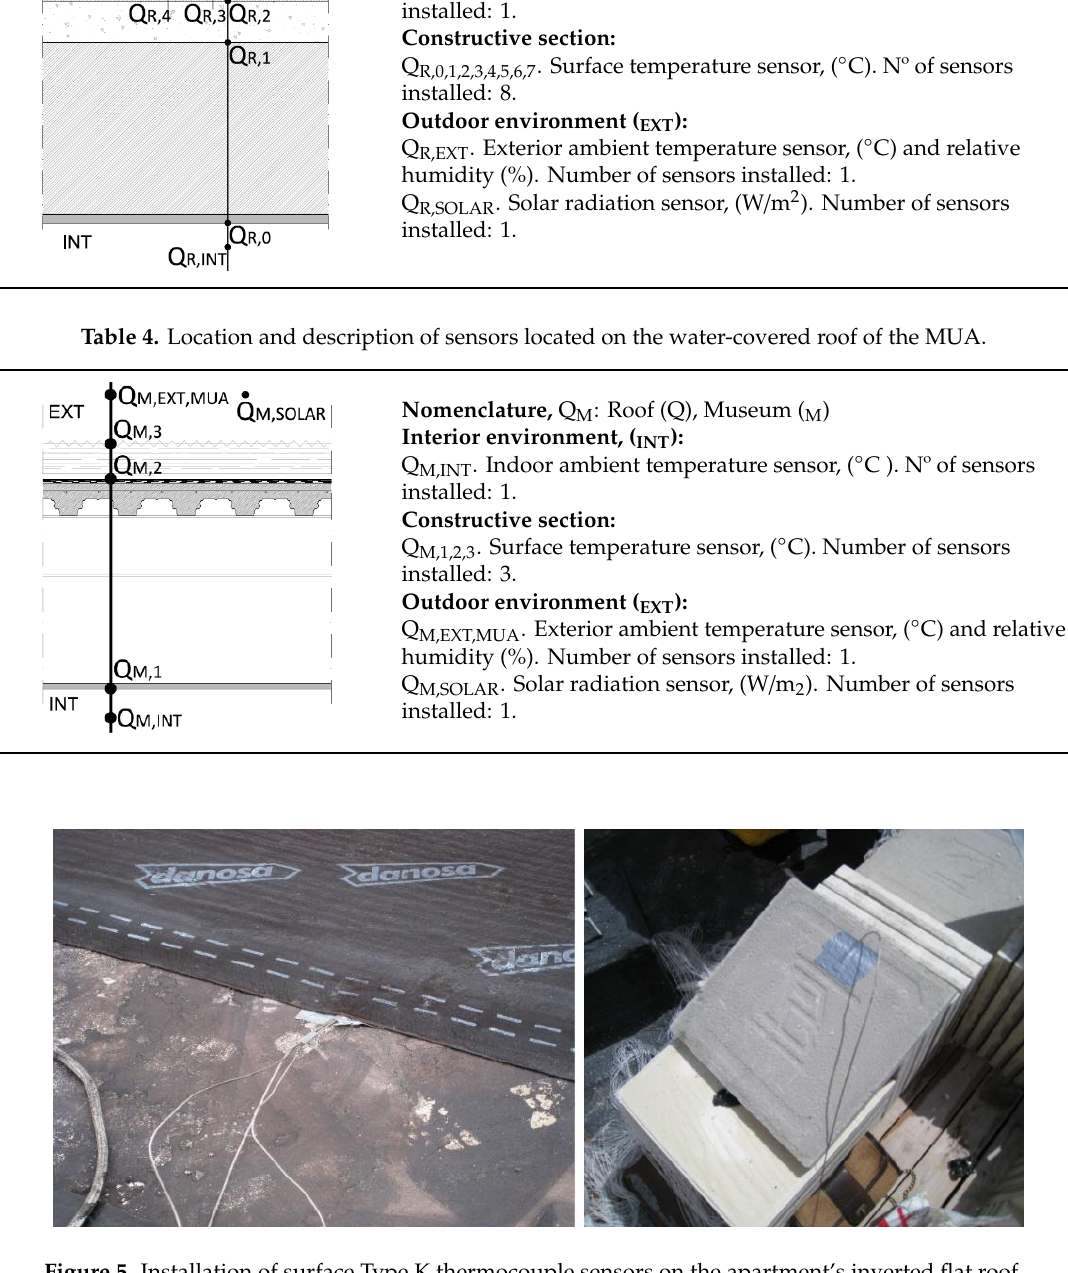
Table 4 . Location and description of sensors located on the water-covered roof of the MUA.